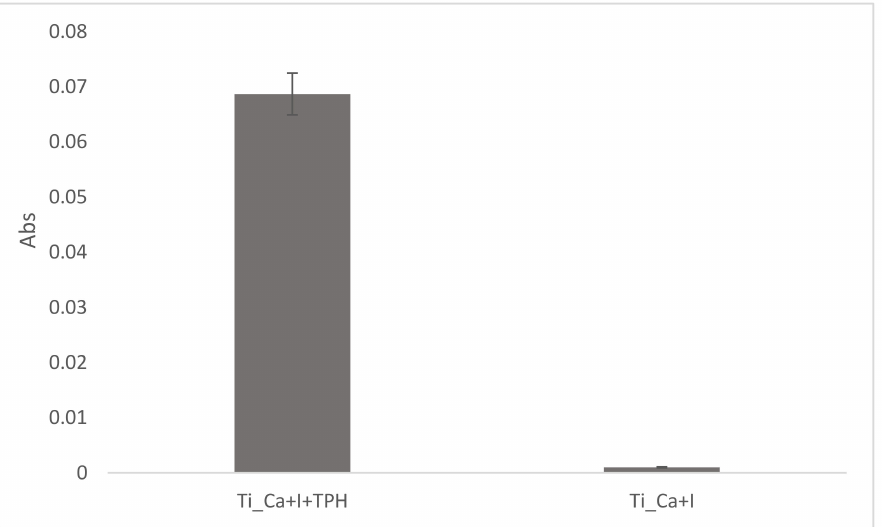
Figure 7. The redox activity in absorbance of polyphenols grafted on the surfaces, measured through the modified Folin–Ciocalteu method, of Ti_Ca+I+TPH and Ti_Ca+I samples.